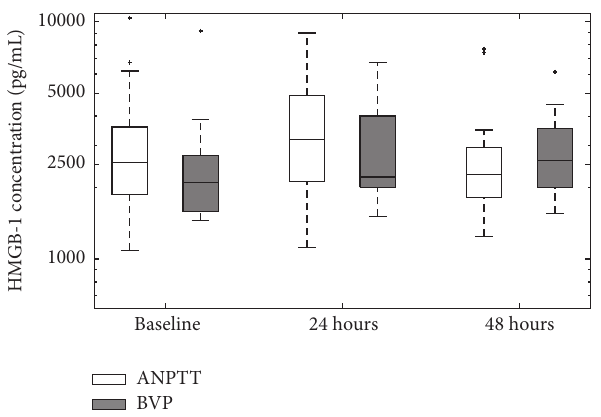
Figure 2: Plasma HMGB-1 levels in relation to TAC dressing applied. Outliers are plotted separately and represented as “+”. 22 patients were in each therapeutic